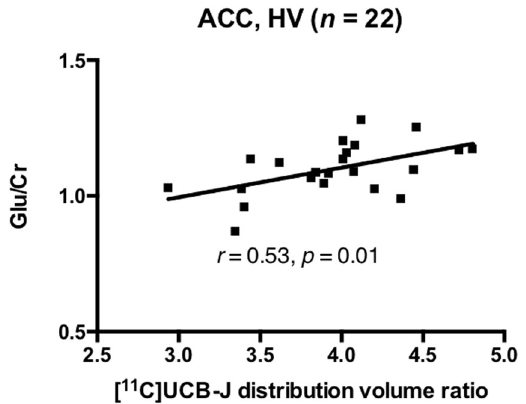
Fig. 3 Synaptic density and glutamate in healthy volunteers. Signi fi cant positive relationship between [ 11 C]UCB-J distribution volume ratio and Glu/Cr levels in the left hippocampus in the healthy volunteer (HV) group.